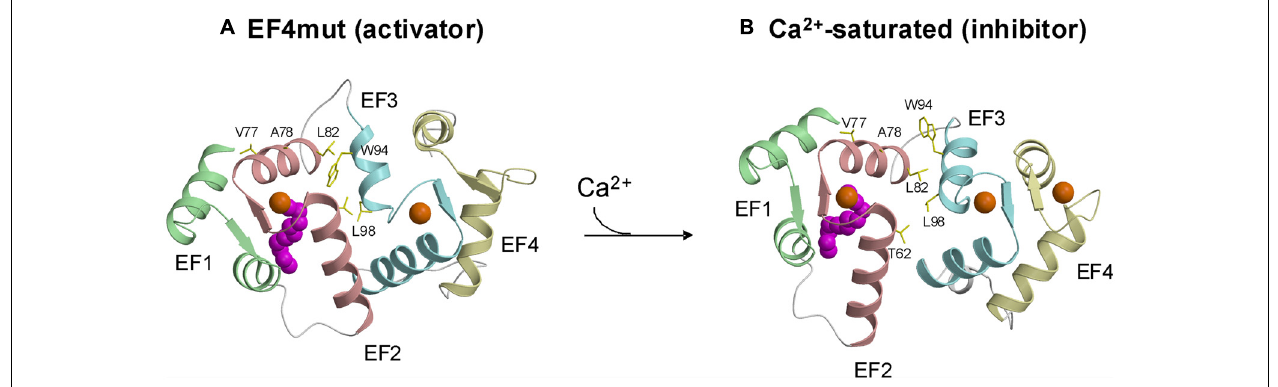
FIGURE 3 | Structures of activator (A) vs. inhibitor forms (B) of GCAP1 adapted from and originally published by Lim etal.